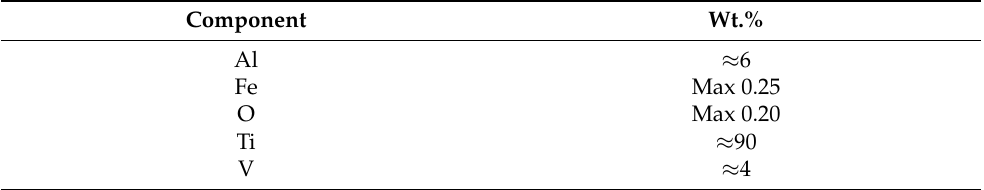
Table 2. Composition of the titanium alloy (Ti-6Al-4V).